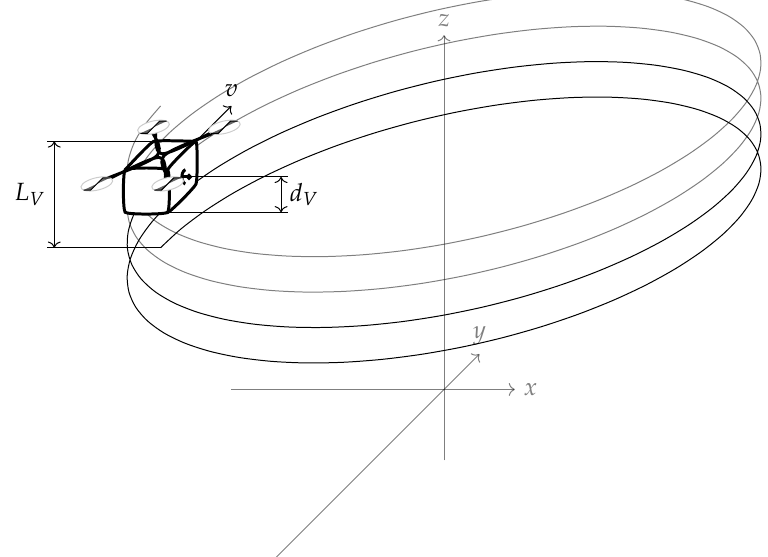
Figure 3. Circular SAR geometry. v denotes the direction of motion of the radar platform, L V is the vertical synthetic aperture size (the distance between the highest and lowest pass), and d V is the vertical sampling distance (the distance between consecutive passes).